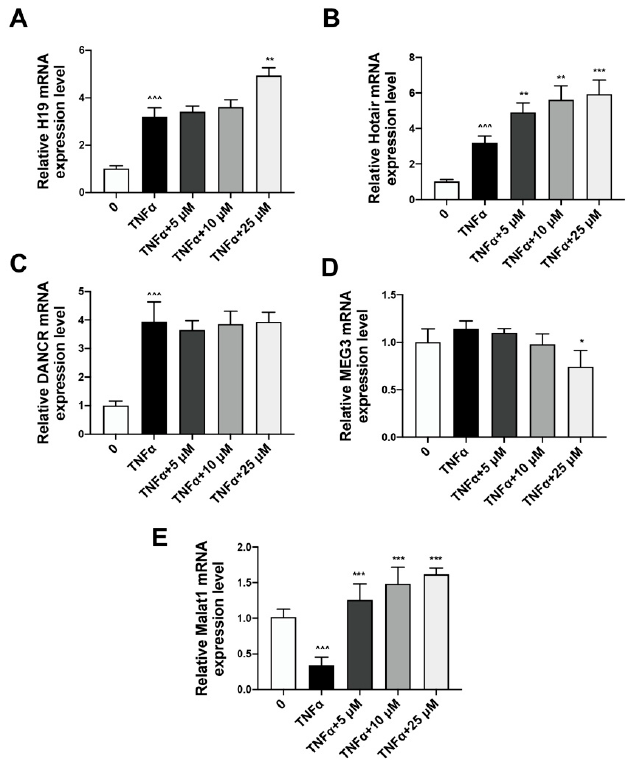
Figure 4. Identification of Malat1 as a quercetin-targeting gene in rescuing TNF α -impaired BMSCs osteogenesis A-E. The expression level of osteoporosis-related lncRNAs in BMSCs after being pre- conditioned with TNF α and treated with quercetin were detected by real-time PCR, including H19 ( A ), Hotair ( B ), Dancr ( C ), MEG3 ( D ) and Malat1 ( E ) ( n = 6; ˆˆˆ p < 0.001, * p < 0.05, ** p < 0.01, *** p < 0.001).